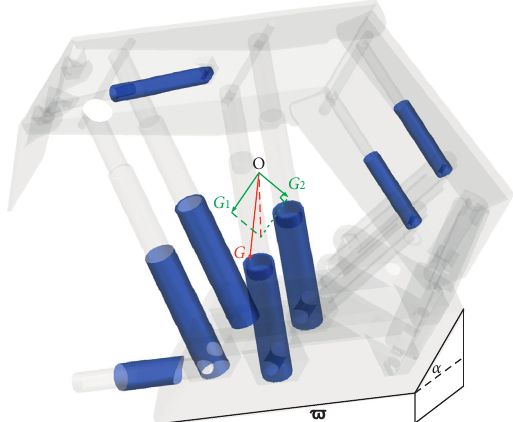
Figure 13: Loading condition of the support, with its self-weight.